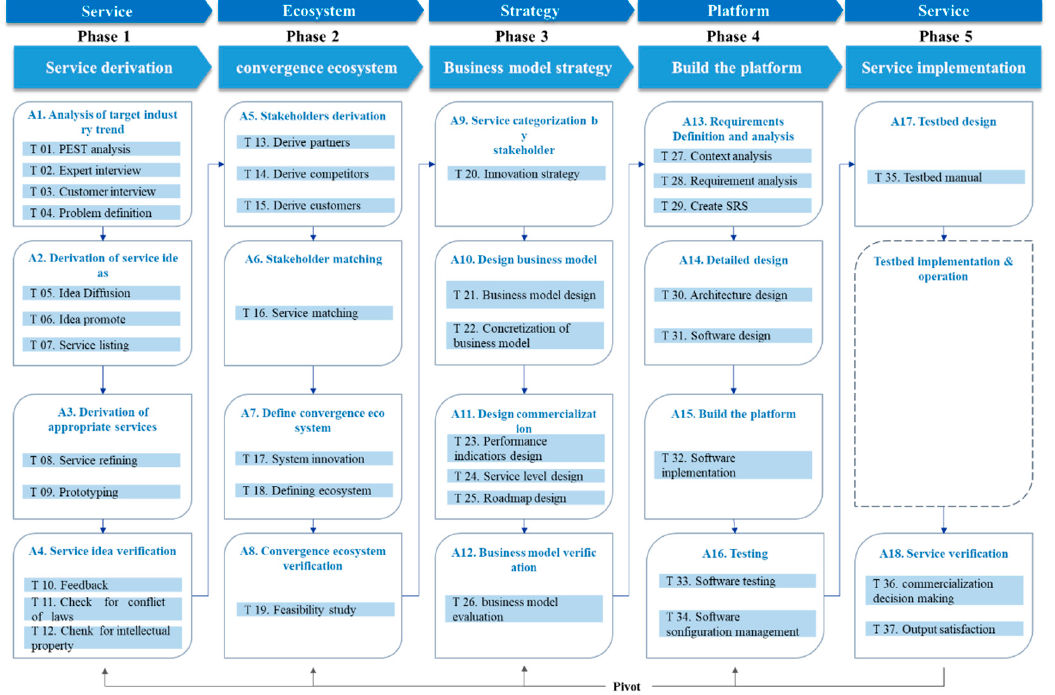
Figure 1. Eco-science Methodology Framework.